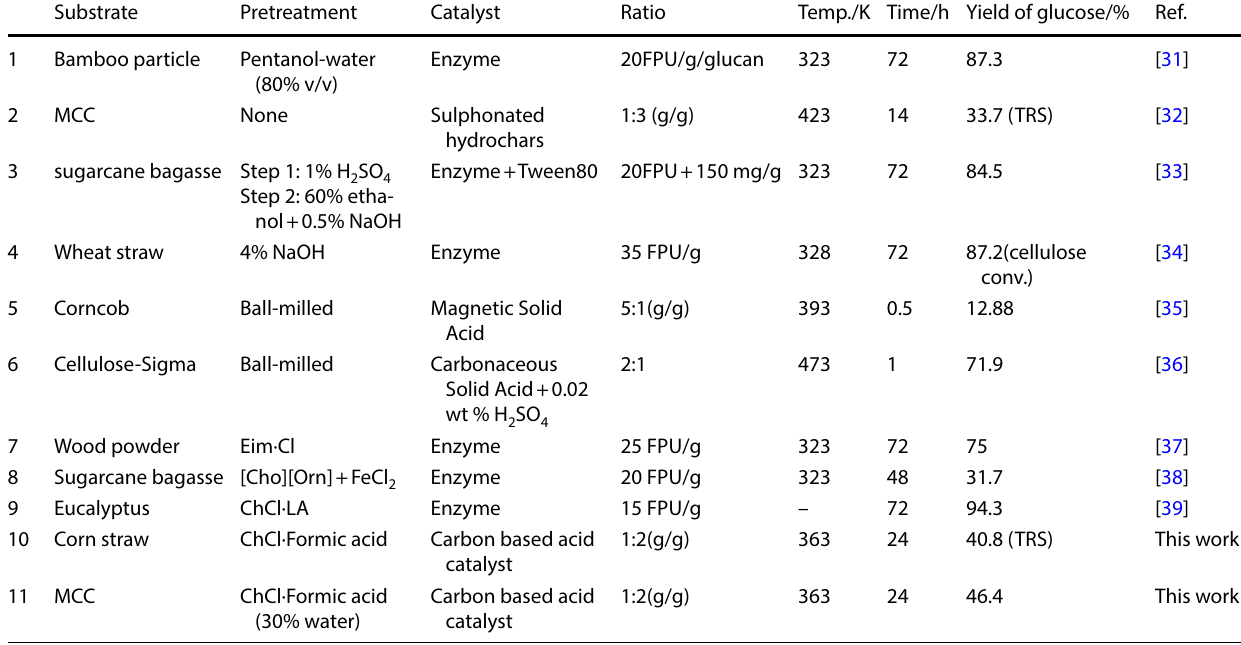
Table 3 Hydrolysis of lignocellulose pretreated by different method and then catalysed by various catalysts